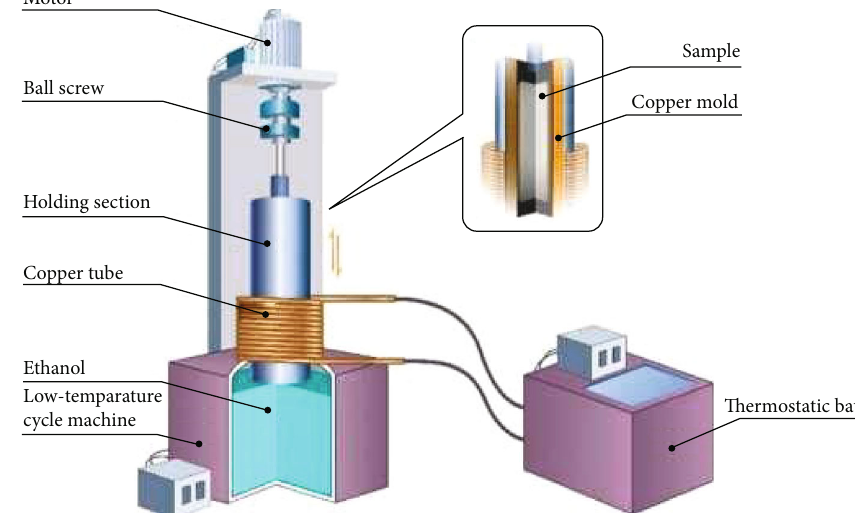
Figure 6: Schematic diagram of unidirectional freeze casting [50].